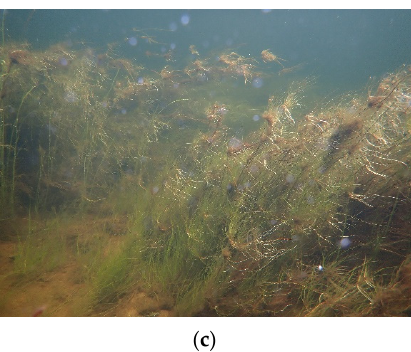
Figure 4. Juncus bulbosus in River Otra, Rysstad, Southern Norway. ( a ) Large growth form. ( b ) Rosette growth form in the foreground; also note the white roots in the background ( c ) stem with annual shoots. Photos by Benoît O.L. Demars.